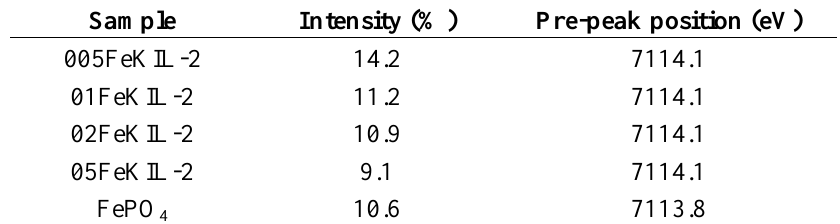
Table 2. Fe K-edge X-ray absorption near edge structure (XANES) data on the pre-edge resonance position and intensity for the FeKIL-2